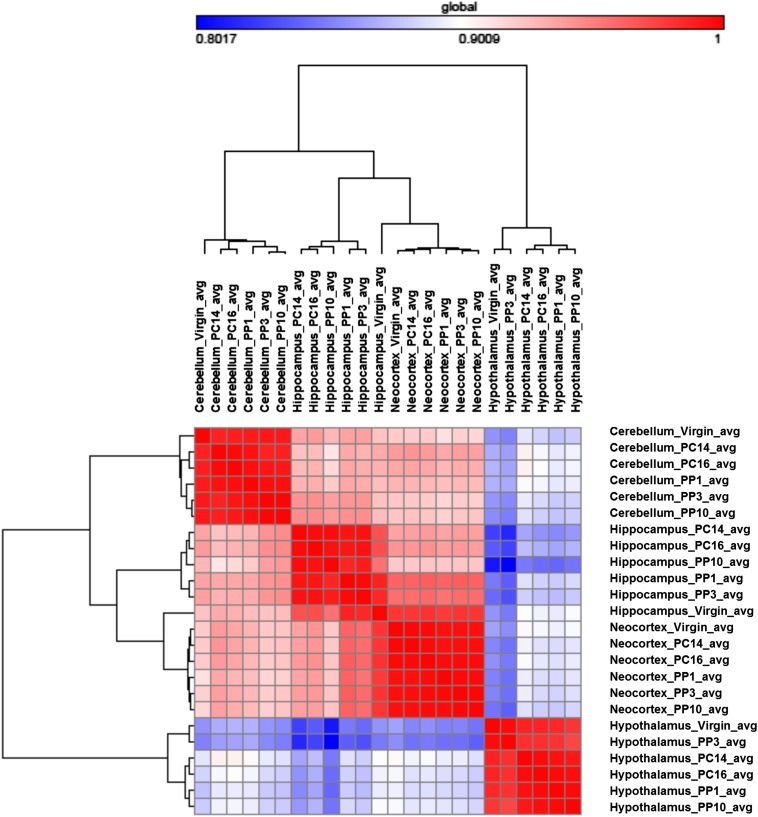
Heat map of sample distance and similarity matrix. The set of 3737 genes that showed differential expression in at least one pairwise comparison was used for this analysis. For each gene, the averaged FPKM (Fragments Per Kilobase of Exon Per Million Fragments Mapped) values were used to generate the similarity of expression plot between time points and across brain regions. The hierarchical cluster and the similarity matrix were generated by GENE-E, using the “one minus Pearson correlation coefficient” metric, with the average linkage method (http://www.broadinstitute.org/cancer/software/GENE-E/).